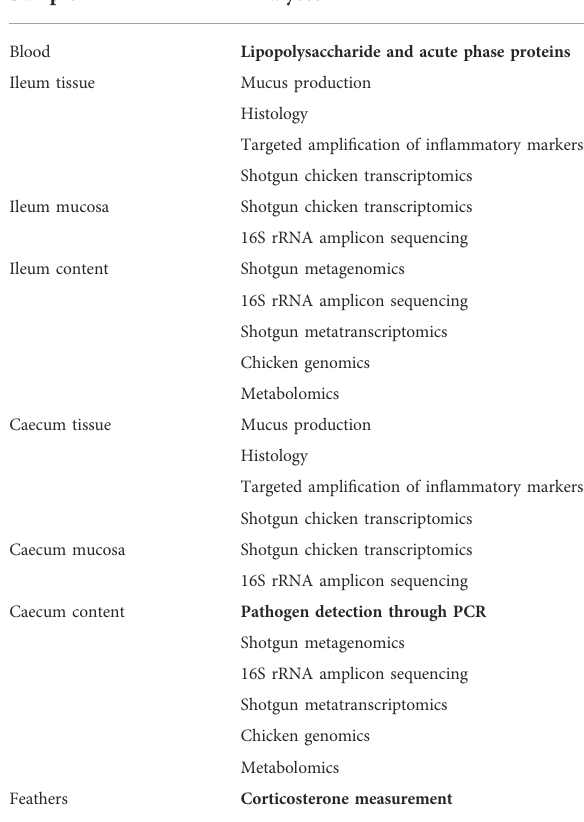
TABLE 1 Overview of the biological samples collected from each individual animal within the project HoloFood and their corresponding multi-omic and complementary analyses with data included in this article